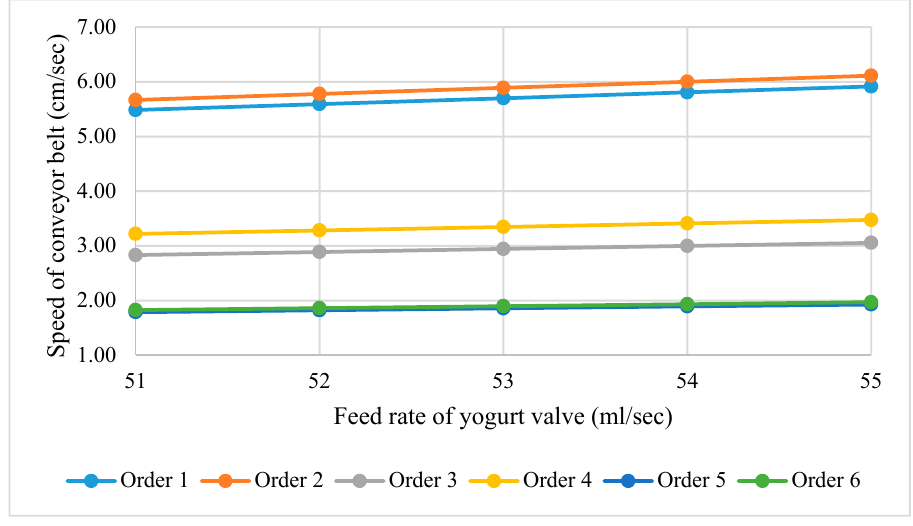
Figure 4. The effect of feed rate of yogurt valve on the feed rate of flavor valve. As shown in Figure 5, an increase in the feed rate of the yogurt valve increases the speed of the conveyor belt linearly. The cups move quickly between any two points on the conveyor belt at the feed rate of the yogurt valve is increased. The required volumes of orders 1 and 2, 3 and 4, and 5 and 6 are close to each other, and hence their speeds are changing with almost equal rates. An inverse relation was found between the speed of the conveyor belt and the required volume of a cup. The speed of the conveyor belt decreases with the increase in the required volume of a cup.